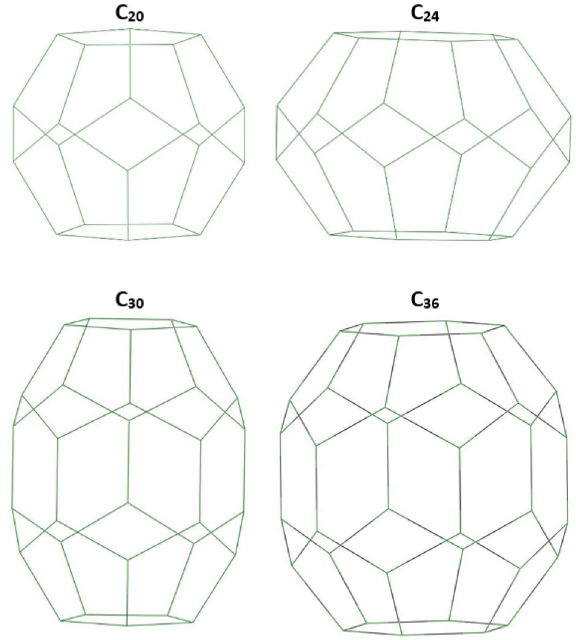
Figure 12. The geometry of the fullerenes, the C 20 , C 24 , C 30 and C 36 structures, are shown in the figure. The C 20 is the smallest stable fullerene. The smallest fullerene has twelve pentagons in its structure, no hexagons. Fullerenes are carbon cages that their structural geometry consists of pentagons and hexagons. They have 12 pentagons, but the number of hexagons can be